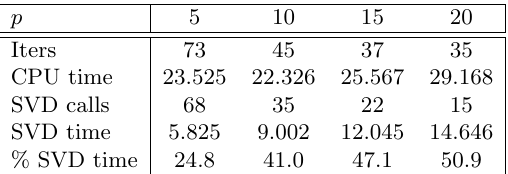
Table 8. Performance of the BRR method for Problem